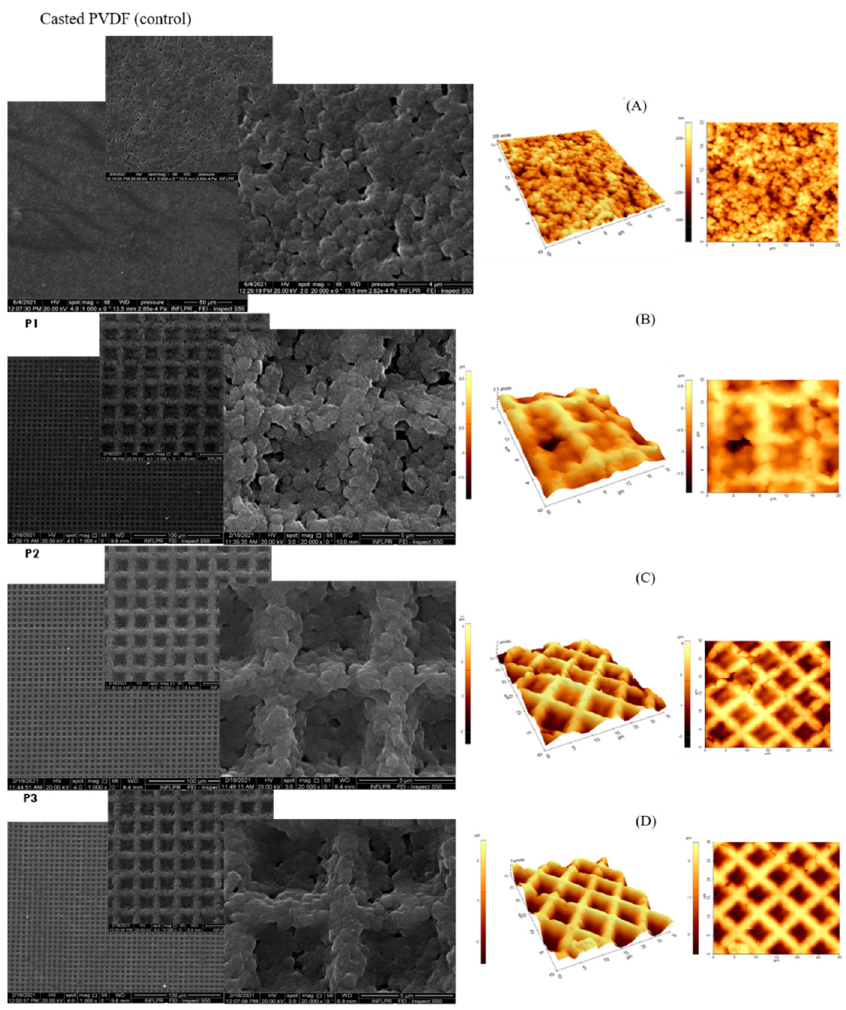
Figure 1. SEM micrographs ( left ) and AFM surface morphology images ( right ) of casted and replicated PVDF (30 × 30 µ m 2 ): casted PVDF ( A ) and microstructured PVDF replicas annealed at 60 ◦ C with different depths: ( B ) P1: 0.8 µ m, ( C ) P2:1.5 µ m, ( D ) P3: 2.5 µ